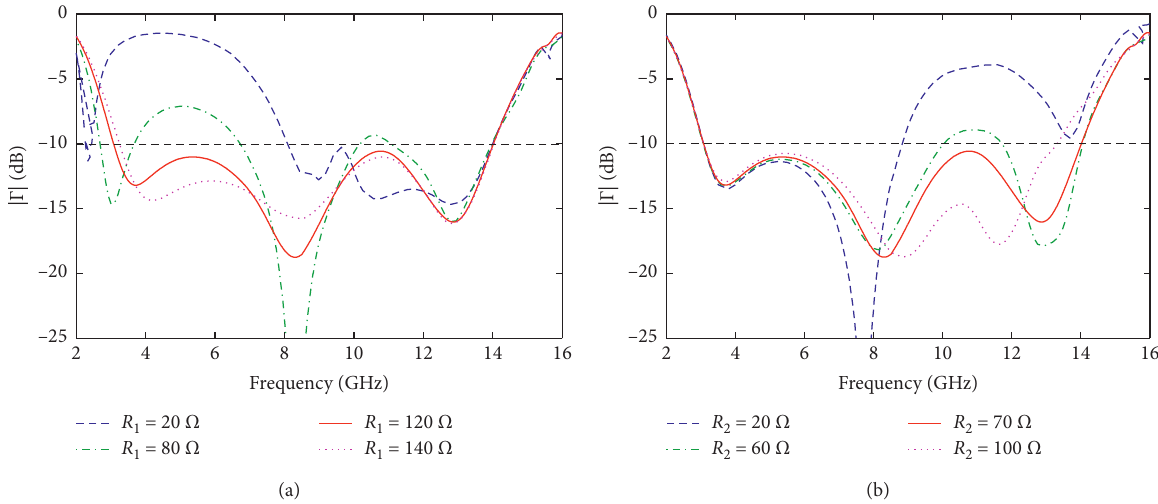
Figure 6: Different frequency responses of the proposed absorber with various values of chip resistors. (a) Different values of R Different values of R . 2